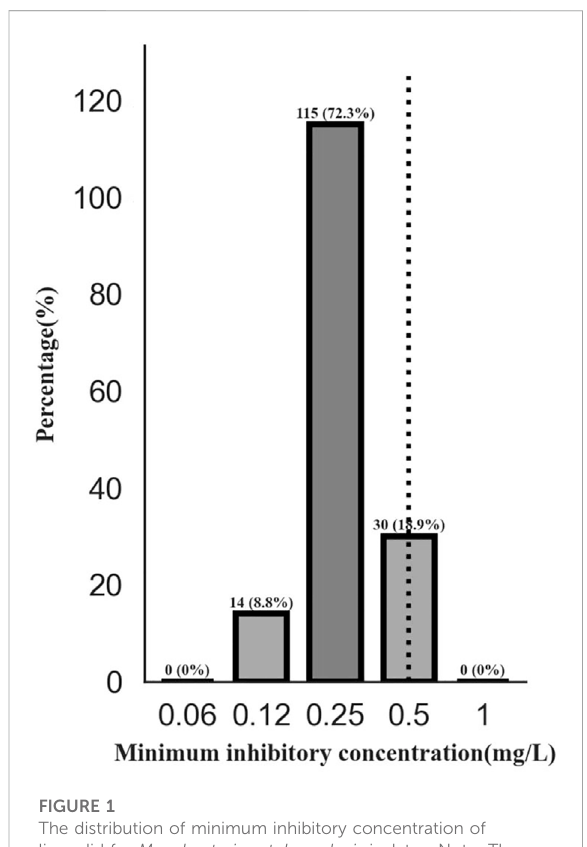
FIGURE 1 The distribution of minimum inhibitory concentration